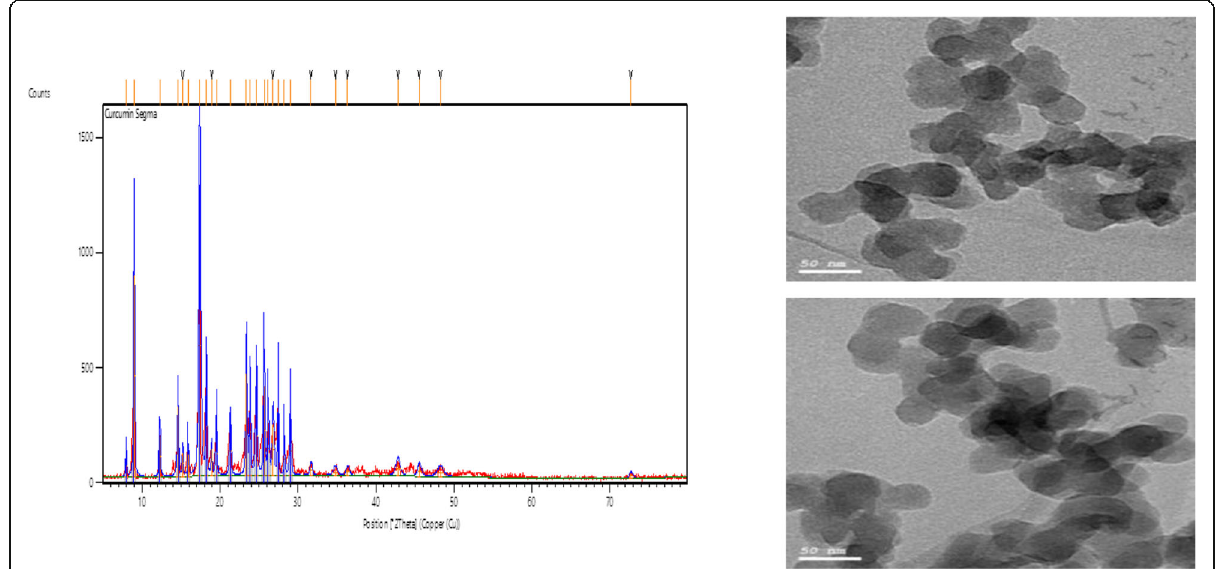
Fig. 1 Pancreas pathology. X-ray diffraction pattern of curcumin particles after annealing at 25 °C (left panel) and transmission electron microscopy images (right panel) of curcumin nanoparticles